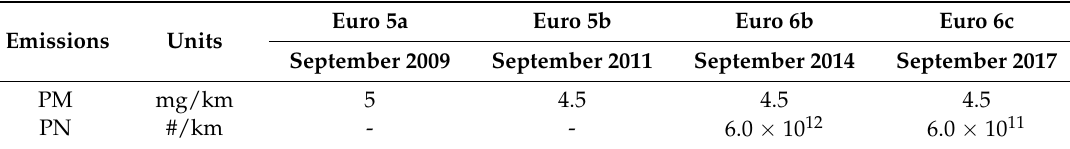
Table 1. EU emissions standards for particulate emissions from GDI-powered